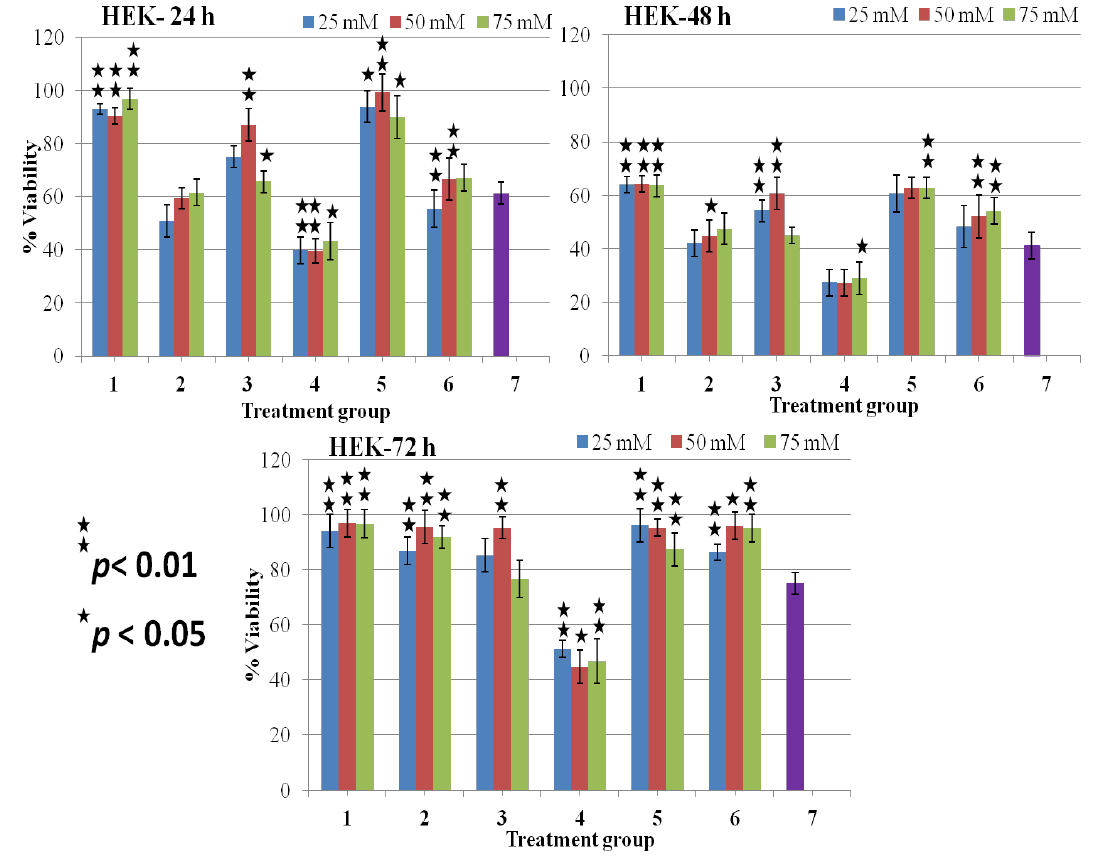
Figure 4. % Viability evaluated from MTT assay on treated HEK non-malignant cells at 24, 48, and 72 h. Data presented are mean ± SD of at least three independent experiments (n = 3) and statistically